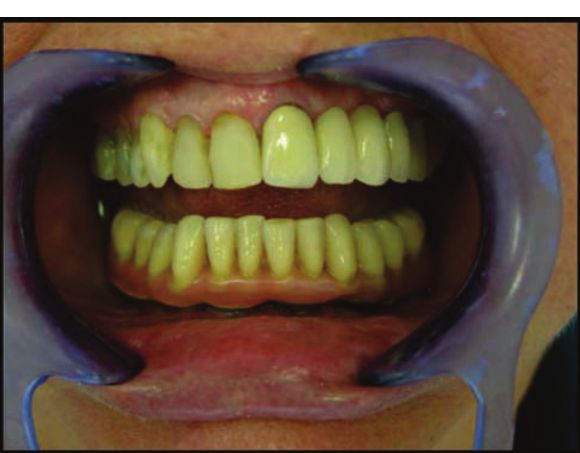
FIGURE 10 – Definitive prosthesis placed in the